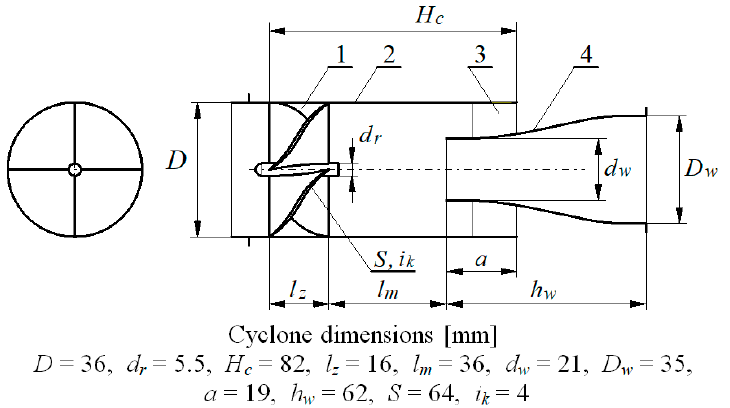
Figure 7. Main elements and characteristic dimensions of axial flow cyclone from special